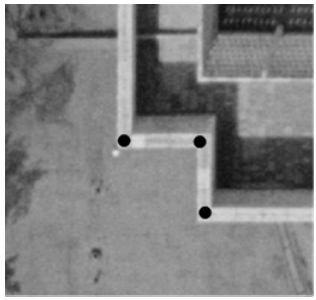
Figure 16. A building with protruding fences with manually selected corner